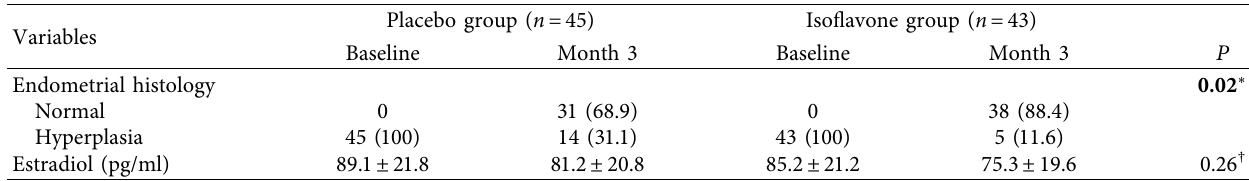
Table 2: Endometrial histology and serum estradiol levels at the baseline and after the 3-month intervention period in women with nonatypical endometrial hyperplasia that received either isofavone or the placebo.